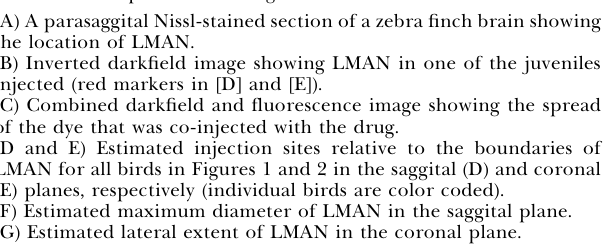
Figure S1. Histology Confirming the Injection Sites for the LMAN Inactivation Experiments in Figures 1 and 2. (A) A parasaggital Nissl-stained section of a zebra finch brain showing the location of LMAN. (B) Inverted darkfield image showing LMAN in one of the juveniles injected (red markers in [D] and [E]). (C) Combined darkfield and fluorescence image showing the spread of the dye that was co-injected with the drug. (D and E) Estimated injection sites relative to the boundaries of LMAN for all birds in Figures 1 and 2 in the saggital (D) and coronal (E) planes, respectively (individual birds are color coded). (F) Estimated maximum diameter of LMAN in the saggital plane. (G) Estimated lateral extent of LMAN in the coronal plane.